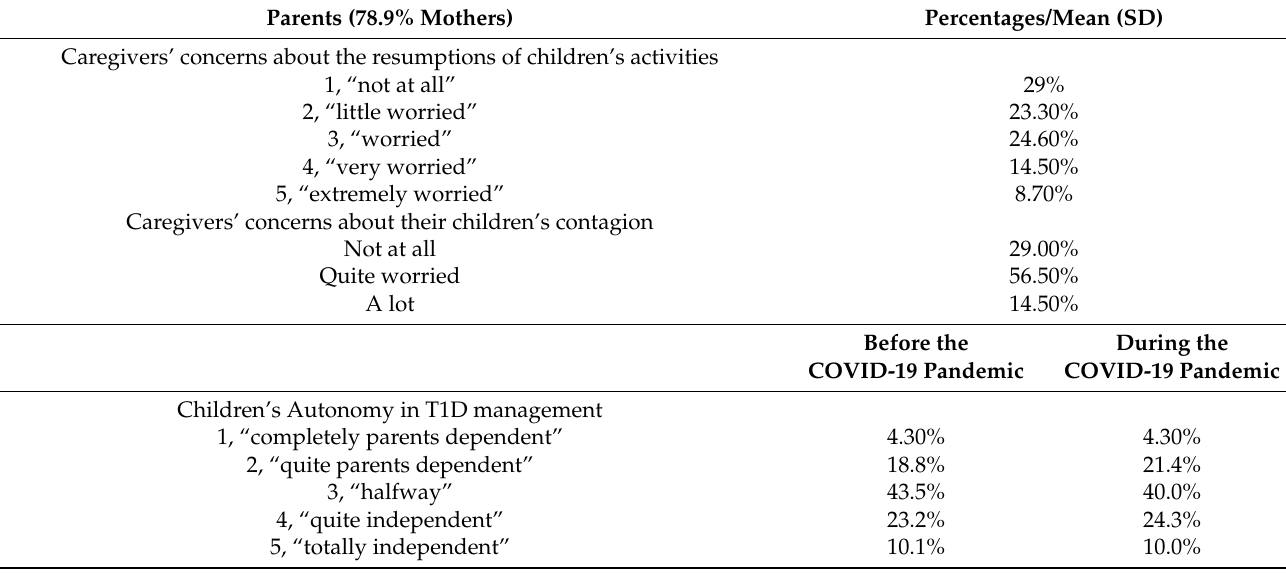
Table 2. COVID-19-related questions from the ad hoc survey for parents and children (valid percentages are